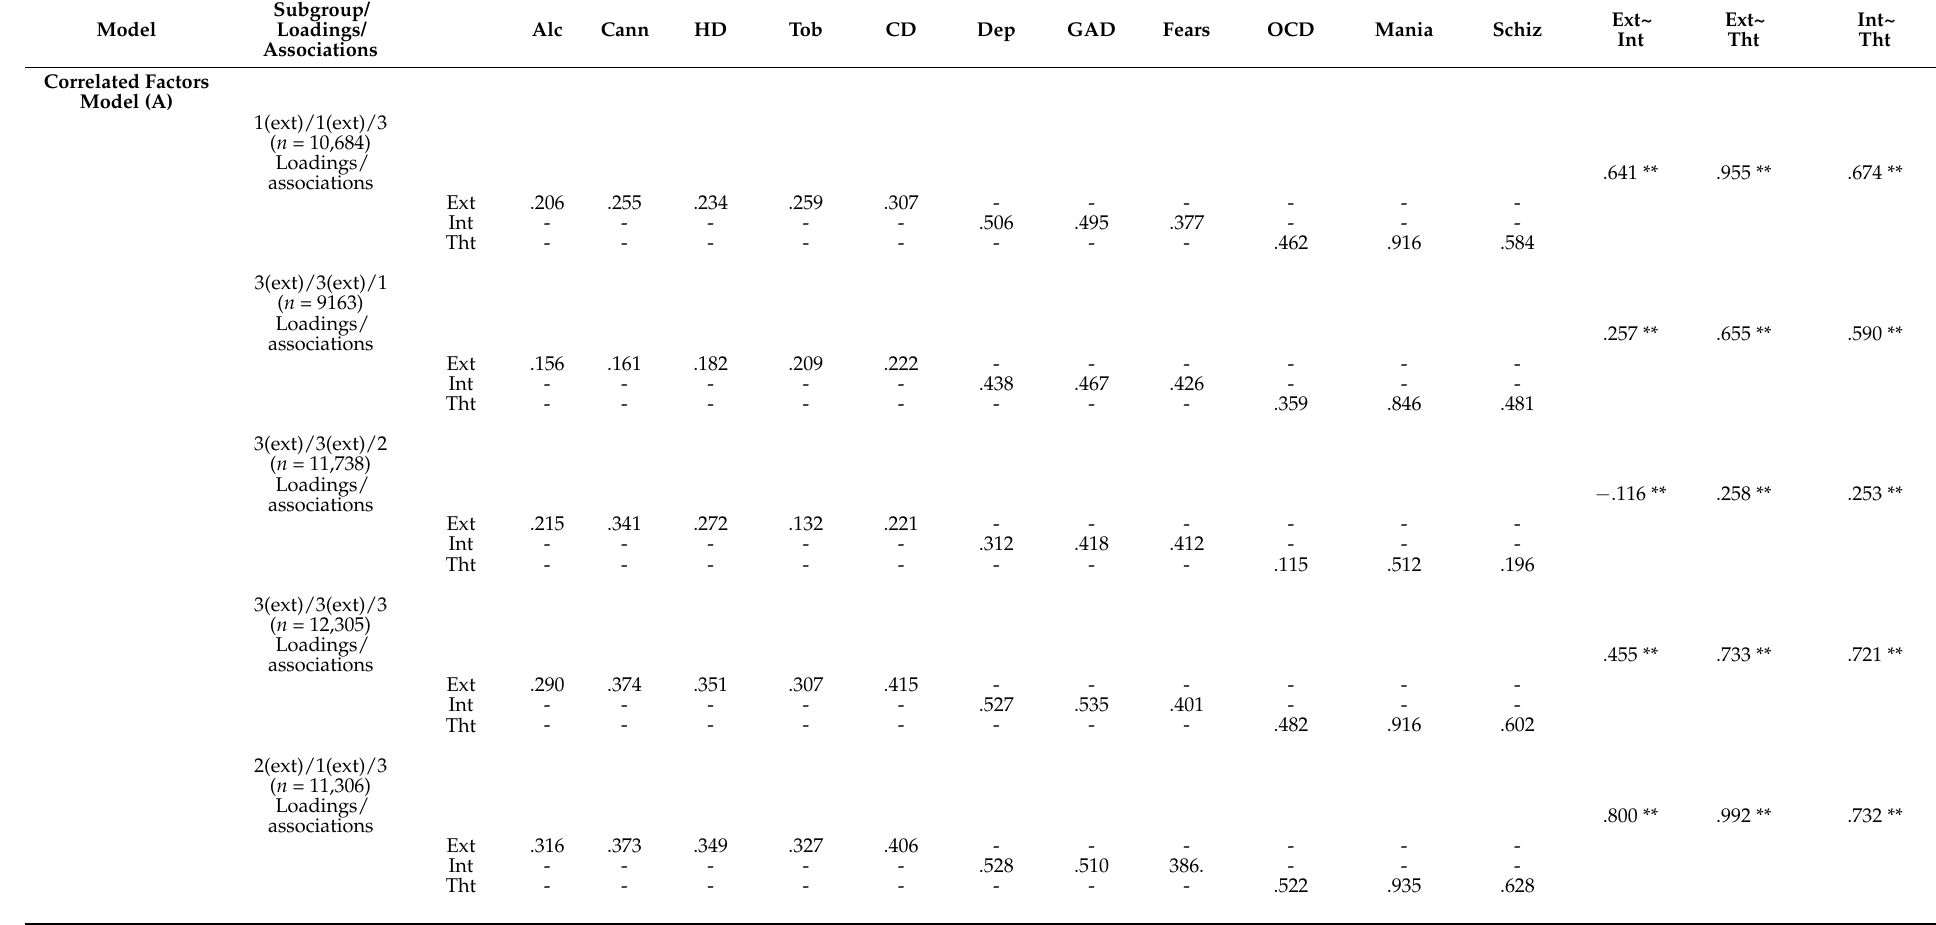
Table 4. Loadings and Covariances for Subgroups That Fit At Least One Model